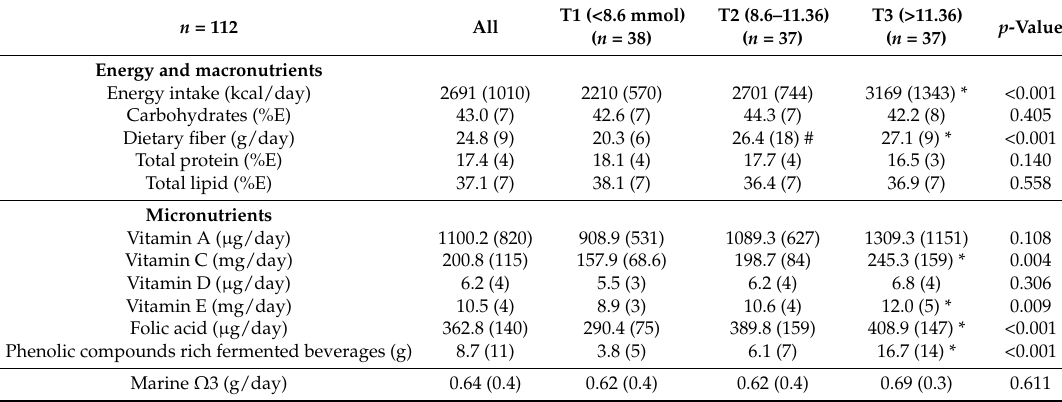
Table 2. Description of the nutrient and food consumption according to tertiles of